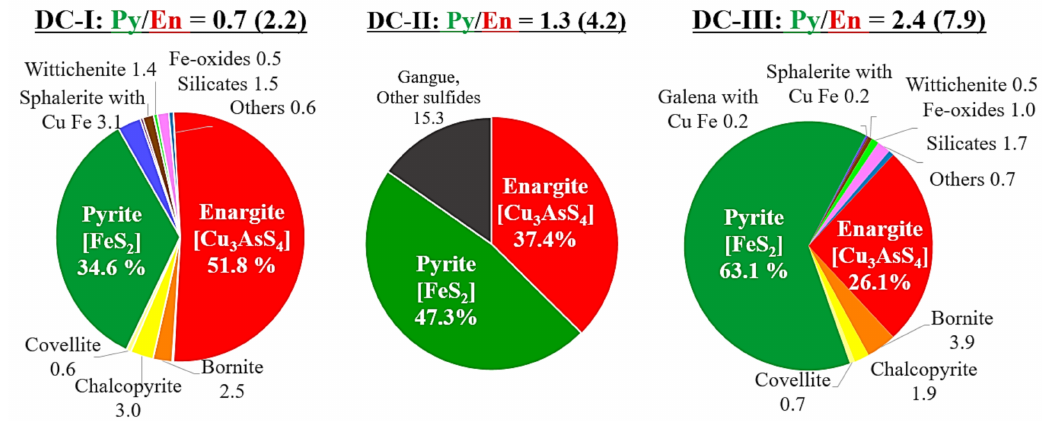
Figure 1. The mineral composition (wt %) of three concentrates used in this study (provided by Sumitomo Metal Mining Co., Ltd. for DC-I, III; JX Nippon Mining & Metals Co., Ltd. for DC-II) based on the scanning electron microscope (SEM)-based mineral liberation analysis (MLA). Py/En indicates the weight or molar (in parenthesis) ratio of pyrite/enargite in the